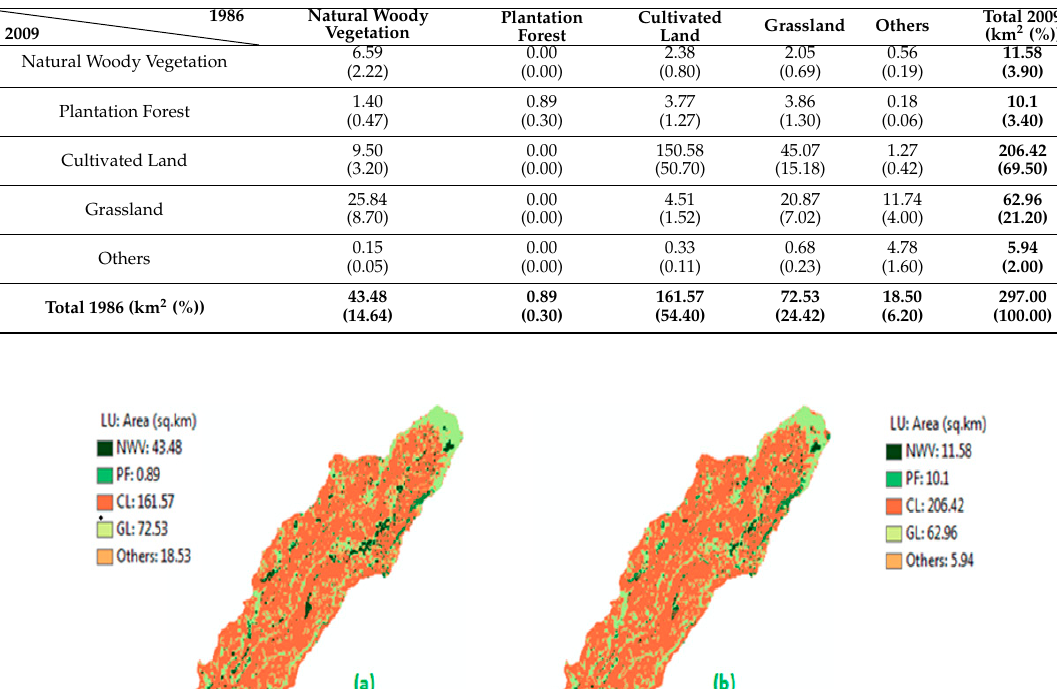
Table 3. Land-use conversion matrix (1986–2009): conversion between land-use classes in km 2 and percentage of total area (in brackets).